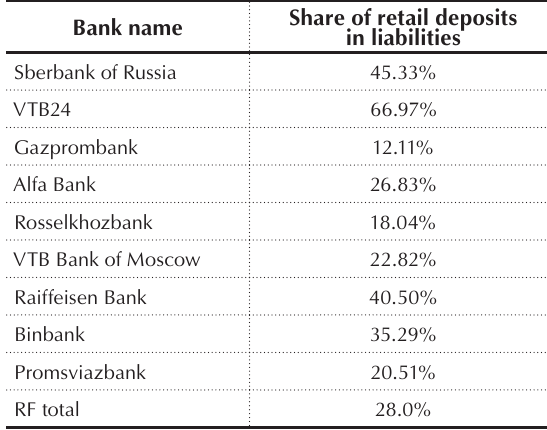
Table 1. (cid:100)(cid:346)(cid:286)(cid:3)(cid:400)(cid:346)(cid:258)(cid:396)(cid:286)(cid:3)(cid:381)(cid:296)(cid:3)(cid:396)(cid:286)(cid:410)(cid:258)(cid:349)(cid:367)(cid:3)(cid:282)(cid:286)(cid:393)(cid:381)(cid:400)(cid:349)(cid:410)(cid:400)(cid:3)(cid:349)(cid:374)(cid:3)(cid:410)(cid:346)(cid:286)(cid:3)